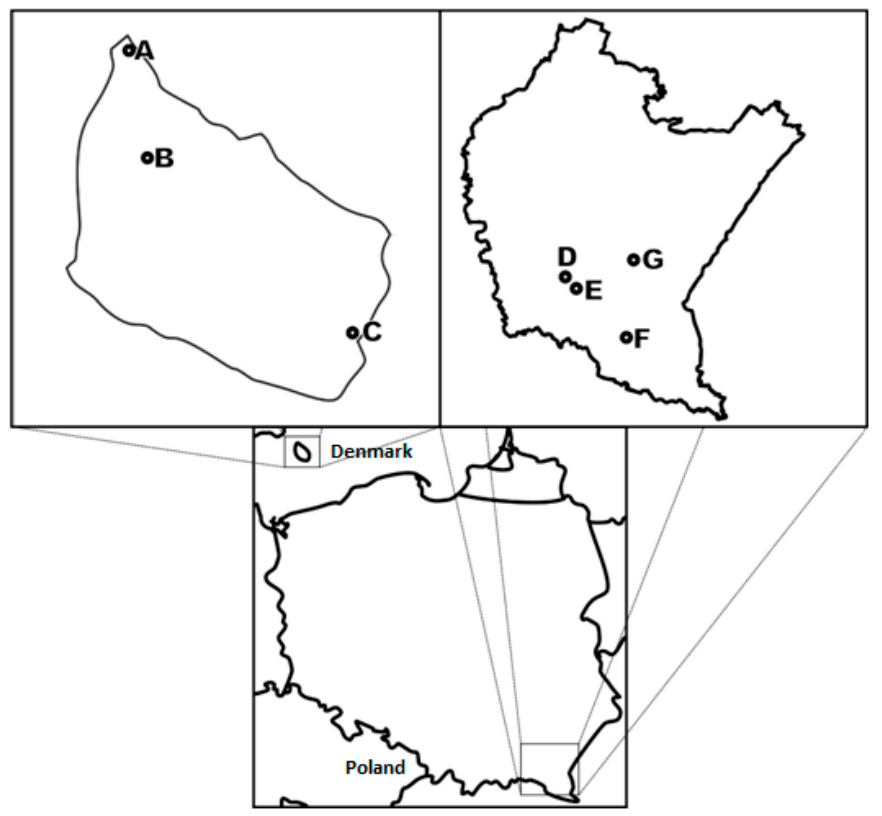
Figure 5. Individual locations of the meadowsweet. Denmark: A: Alinge-Sandvig (55°16 ′ 24.00 ″ N, 14°48 ′ 2.99 ″ E), B: Klemensker (55°10 ′ 27 ″ N 14°48 ′ 24 ″ E), C: Nexo (55°04 ′ N 15°09 ′ E), Poland: D: Iskrzynia (49 ◦ 41 (cid:48) 01 (cid:48)(cid:48) N 21 ◦ 51 (cid:48) 21 (cid:48)(cid:48) E), E: Hacz ó w (49 ◦ 40 (cid:48) 09 (cid:48)(cid:48) N 21 ◦ 53 (cid:48) 28 (cid:48)(cid:48) E), F: Baligr ó d (49 ◦ 20 (cid:48) 14 (cid:48)(cid:48) N, 22 ◦ 17 (cid:48) 09 (cid:48)(cid:48) E), G: Jabłonka (49 ◦ 41 (cid:48) 48 (cid:48)(cid:48) N 22 ◦ 07 (cid:48) 01 (cid:48)(cid:48) E), Source: own